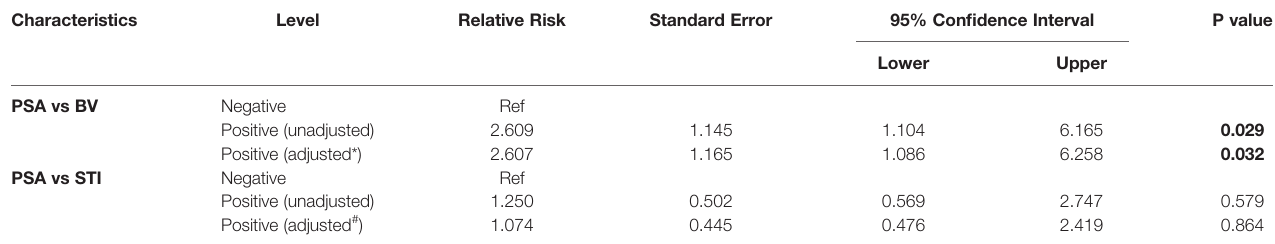
TABLE 2 | Associations between PSA positivity, STI and BV. Characteristics